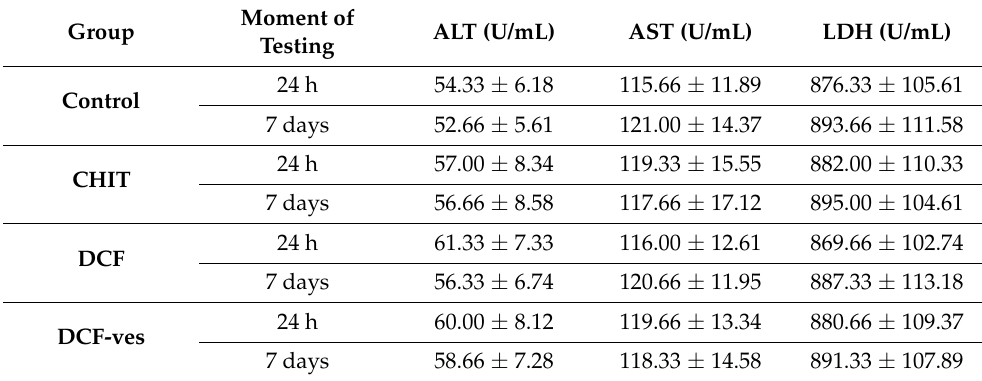
Table 5. Serum levels of ALT, AST and LDH in CHIT, DCF and DCF-ves groups. Values are expressed as the arithmetic mean ± S.D. of the average values for 6 animals per group.